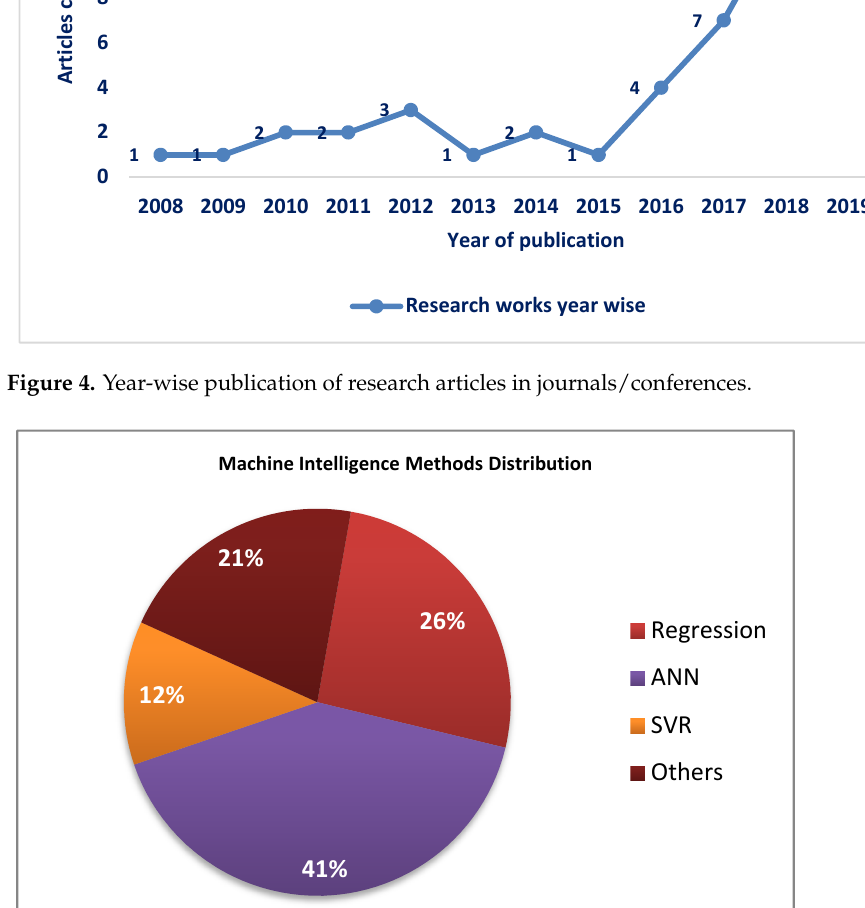
Figure 4. Year-wise publication of research articles in journals/conferences.